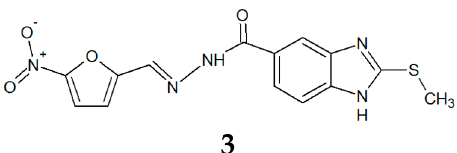
Figure 1. Structure of TbTIM inactivators.